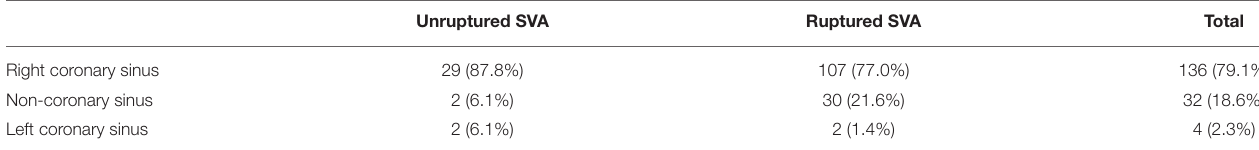
TABLE 1 | Origin of sinus of Valsalva aneurysms (SVAs) diagnosed at FuWai Hospital from February 1, 2007 to January 31, 2012. Unruptured SVA Ruptured SVA Total Right coronary sinus 29 (87.8%) 107 (77.0%) 136 (79.1%) Non-coronary sinus 2 (6.1%) 30 (21.6%) 32 (18.6%) Left coronary sinus 2 (6.1%) 2 (1.4%) 4 (2.3%) SVA, sinus of Valsalva